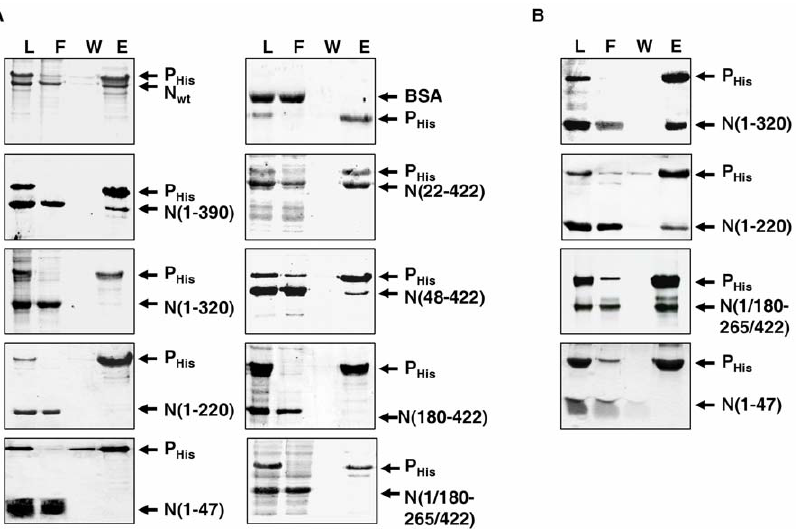
Figure 5. N protein utilizes two separate domains for interacting with P in its monomeric and oligomeric forms. N-terminally His- tagged P protein (His-P) was allowed to interact with either wild-type N or different N mutants in 100 mM NaCl TET buffer containing 10 mM Imidazole for 30 minutes at 4 u C. Reaction mixtures were applied to Ni-NTA column and elution profile assayed by silver staining. L- loading; F- flow through; W- 10 mM Imidazole wash; E- 250 mM Imidazole elution. (A) In the absence of 1% DOC treatment. Bovine Serum Albumin (BSA) was used as negative control. (B) Wild-type N or N mutants were pre-incubated with 1% DOC for 30 minutes, followed by dialysis in presence of His-P, before applying to Ni-NTA column. Samples were resolved in 12% SDS-PAGE and visualised by Coomasie brilliant blue